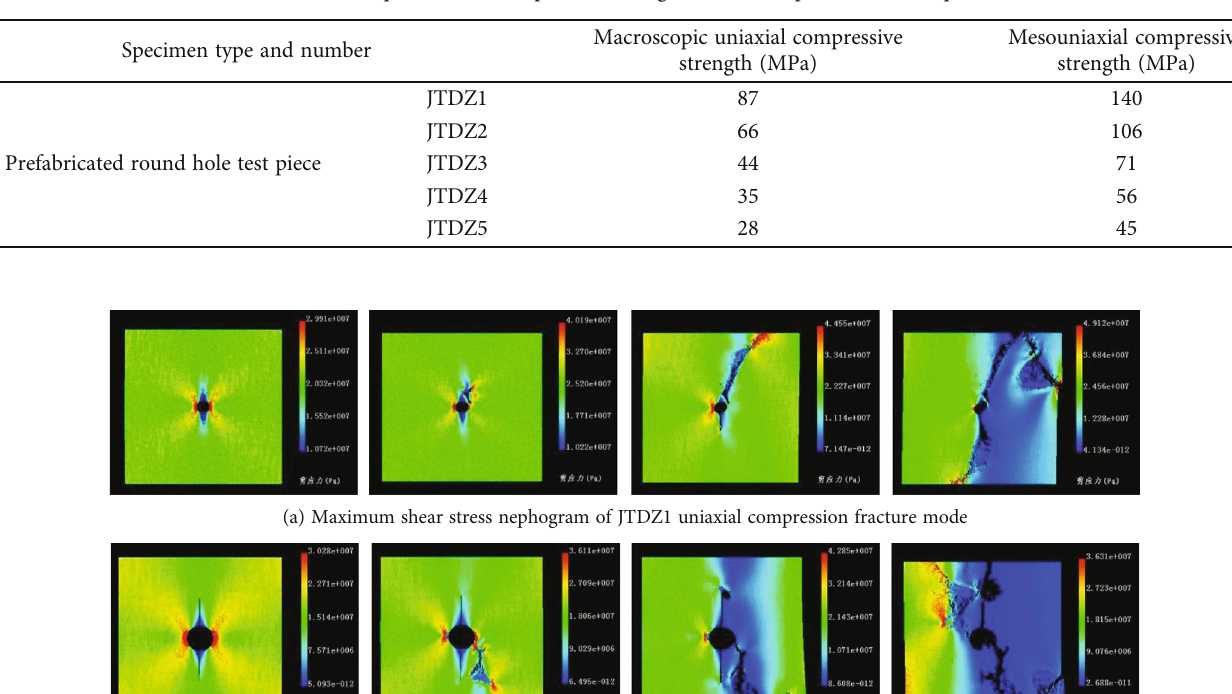
Table 2: Table of mesoscopic uniaxial compressive strength of marble specimens with open circular holes.